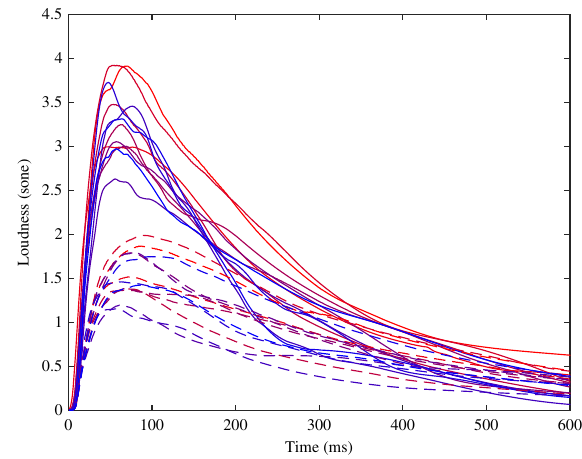
Figure 3. Short-term time-varying loudness computed from plectrum-plucked notes from the fi rst octave on the top string of the banjo (solid lines) and the guitar (dashed lines).